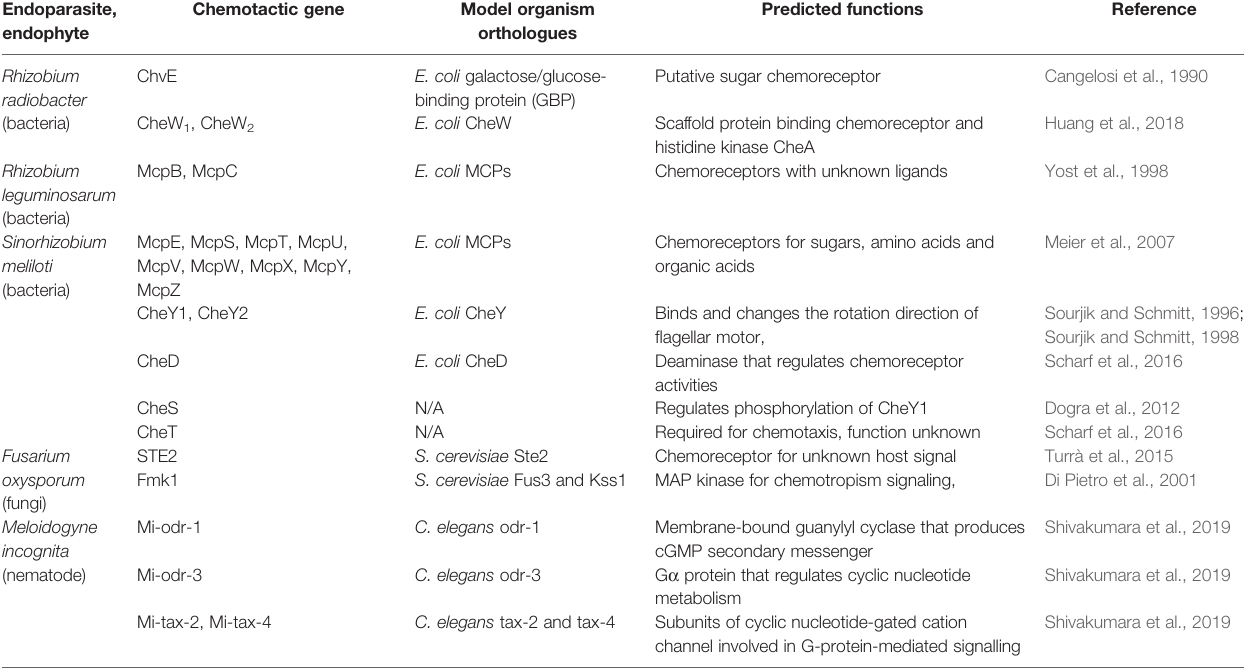
TABLE 1 | Chemotactic genes of endoparasites and endophytes discussed in this